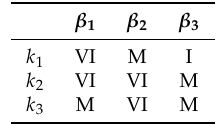
Table 2. Attribute rating linguistic variables.